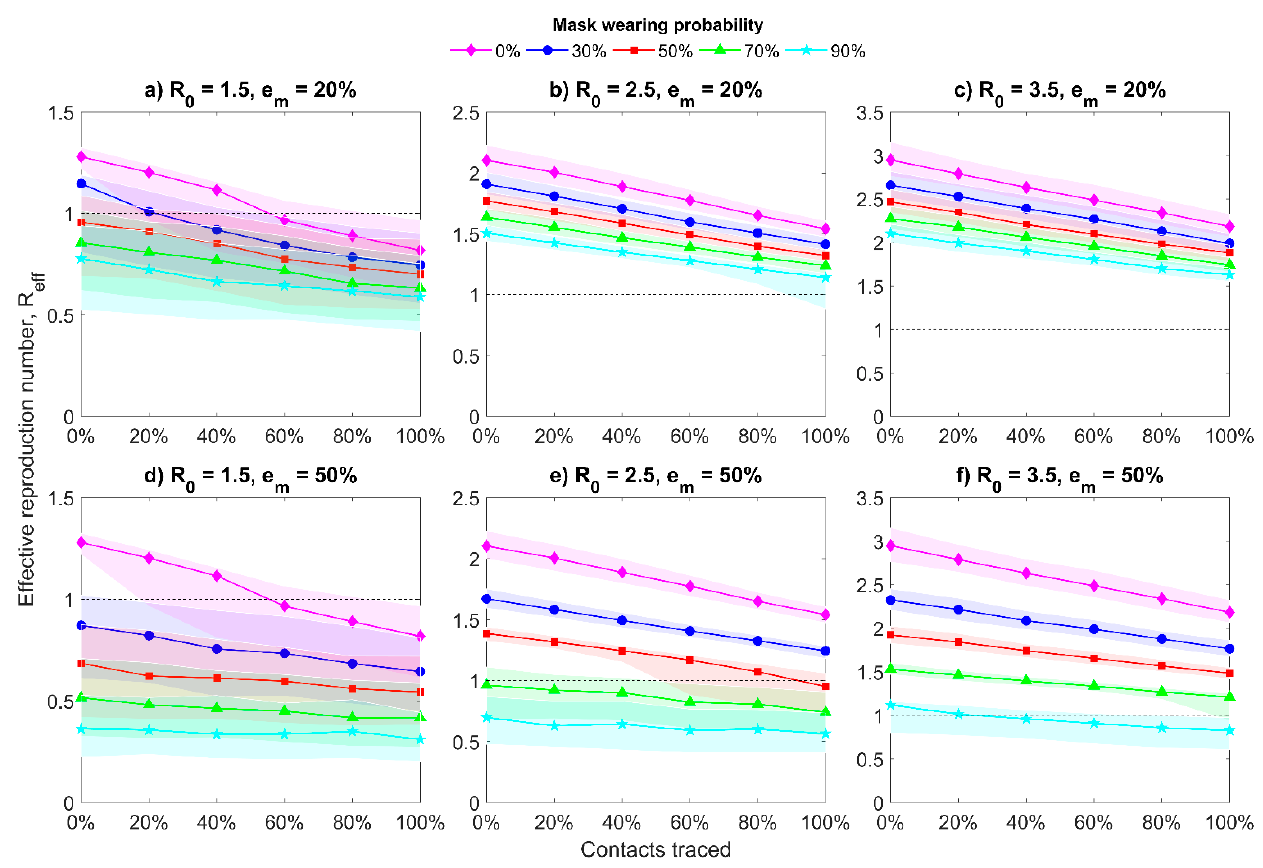
Figure 2. Median of effective reproduction number with interquartile range. Twenty initial symptomatic cases, 20 initial asymptomatic cases, all people wear masks, and the mask hinders spreading and protects from getting infected with different mask efficiency e m , R a = 0.75 · R 0 , 4 days of mean delay, and 40% transmission before symptoms. Top row graphics ( a–c ) represent results for homemade masks, bottom row graphics ( d–f ) represent results for medical masks.